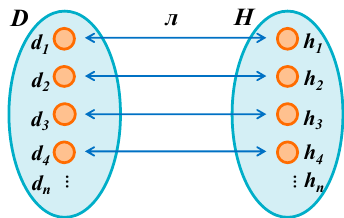
Figure 6. Mapping relation between the navigation safety level and the NSD.